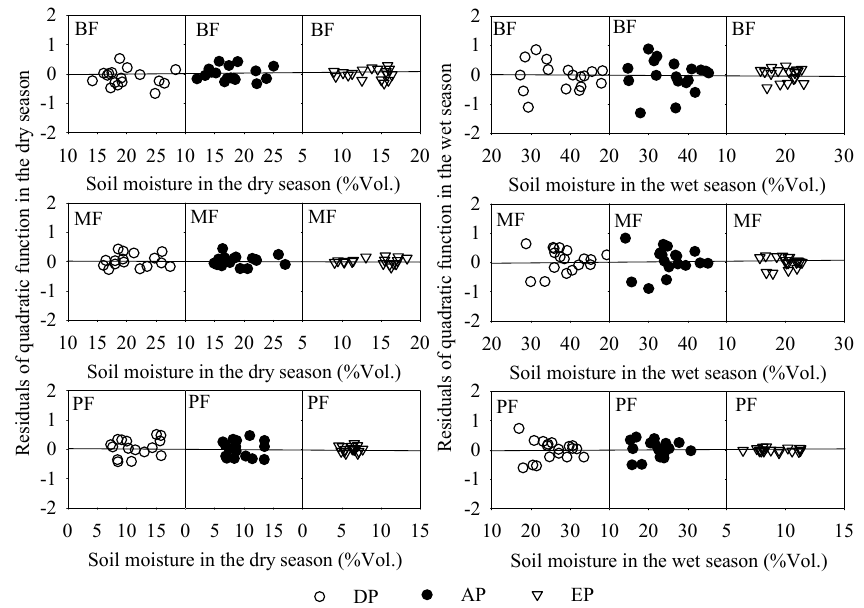
Fig. A5. Residual plots for the models of soil respiration rate ( R , µmolCO 2 m − 2 s − 1 ) and soil moisture of the top 5cm soil layer ( M , %vol.) (quadratic equation: R = a 0 M 2 + c 0 M + d 0 ) under different seasons and different precipitation treatments at the DNR forests. The treatments are as follows: precipitation exclusion (EP), ambient precipitation (AP), and double precipitation (DP). The forests are as follows: broadleaf forest (BF), mixed forest (MF), and pine forest